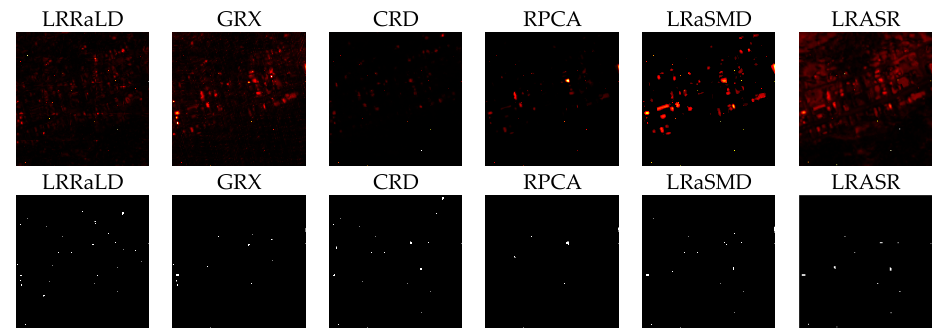
Figure 10. Detection results under complex background using different methods: ( top ) 2-D display; and ( bottom ) binary results when PFA equals 0.001.